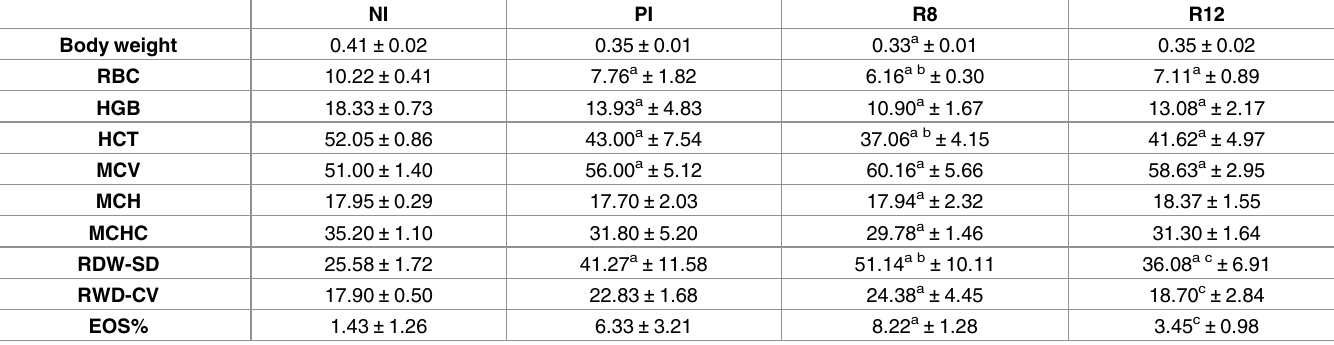
Table 1. Rat body weight and hematological parameters in each rat group at the end of the experiment.